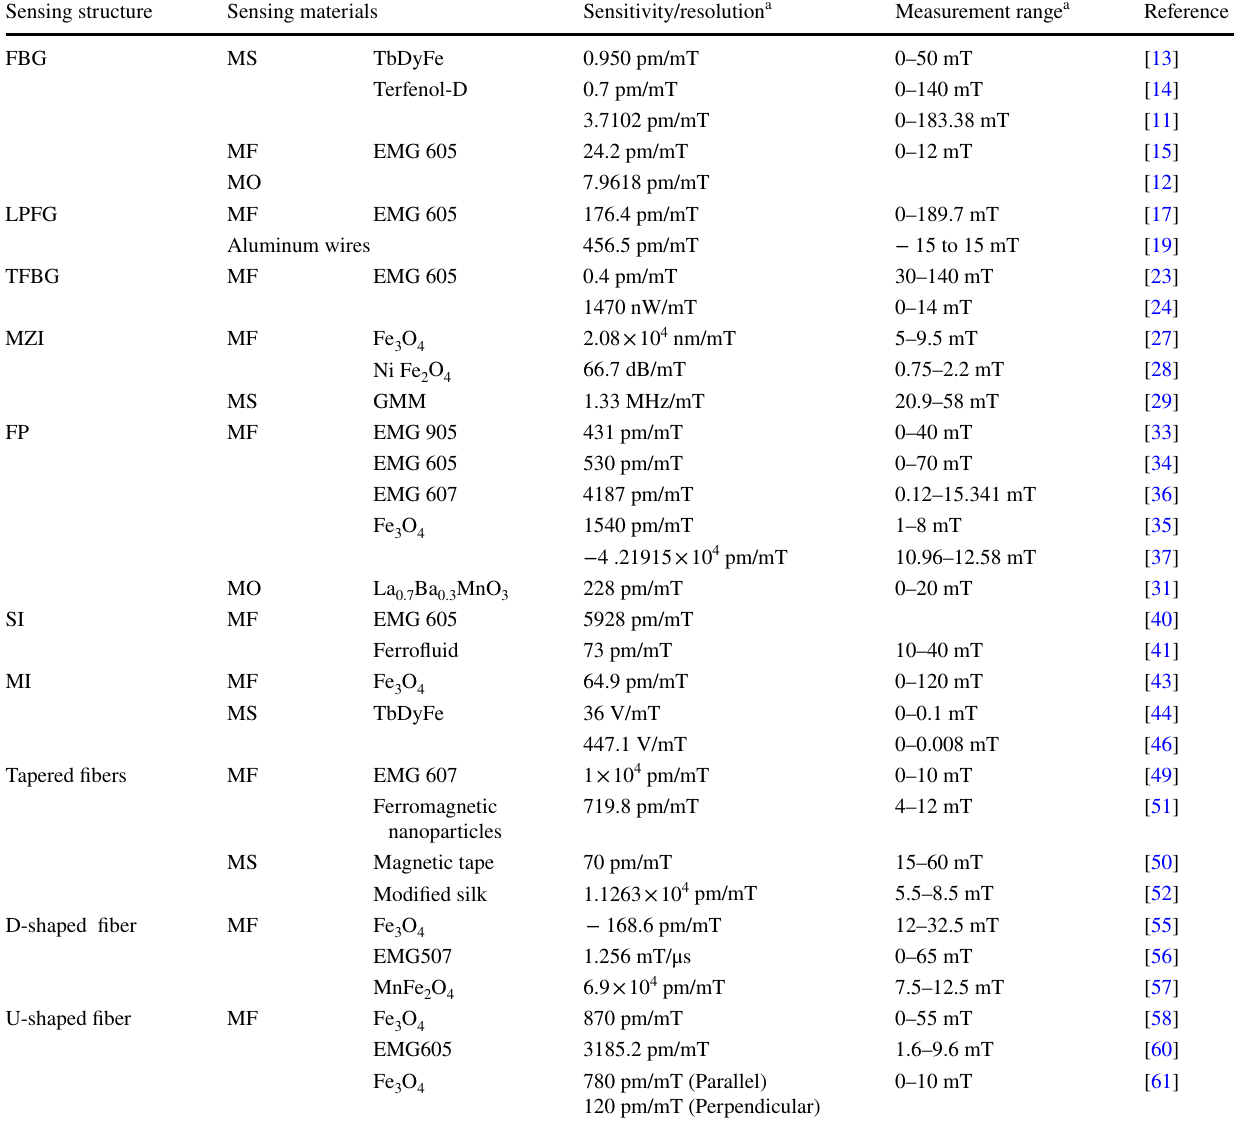
Table 1 Performance parameters of fiber optic magnetic field